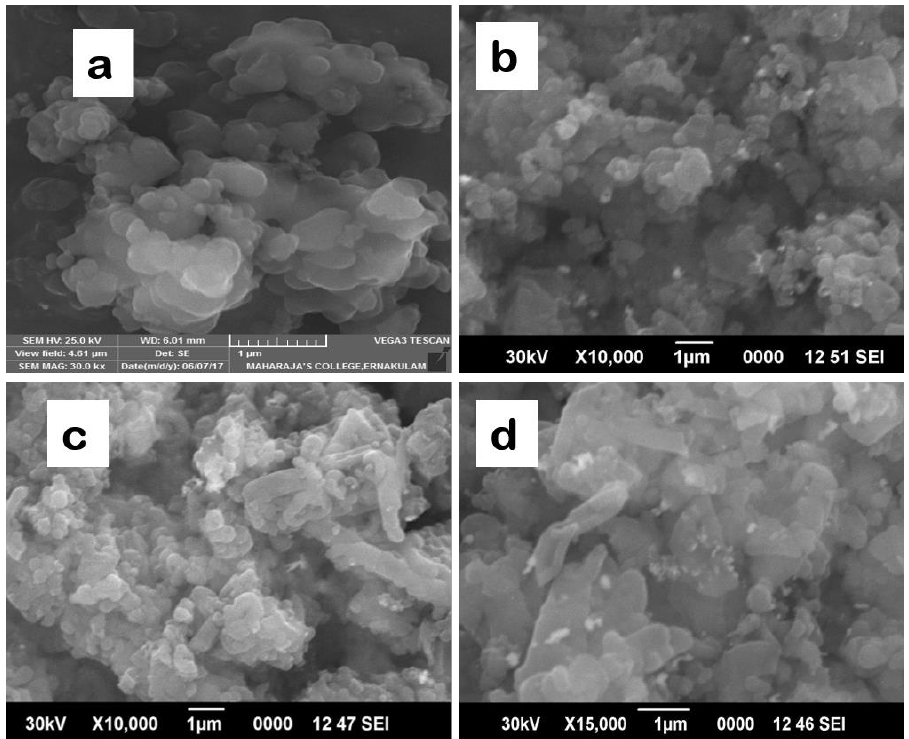
Fig. 4. SEM images of (a) PNA, (b) Gr-Ag-5/PNA, (c) Gr-Ag-10/PNA and (d)